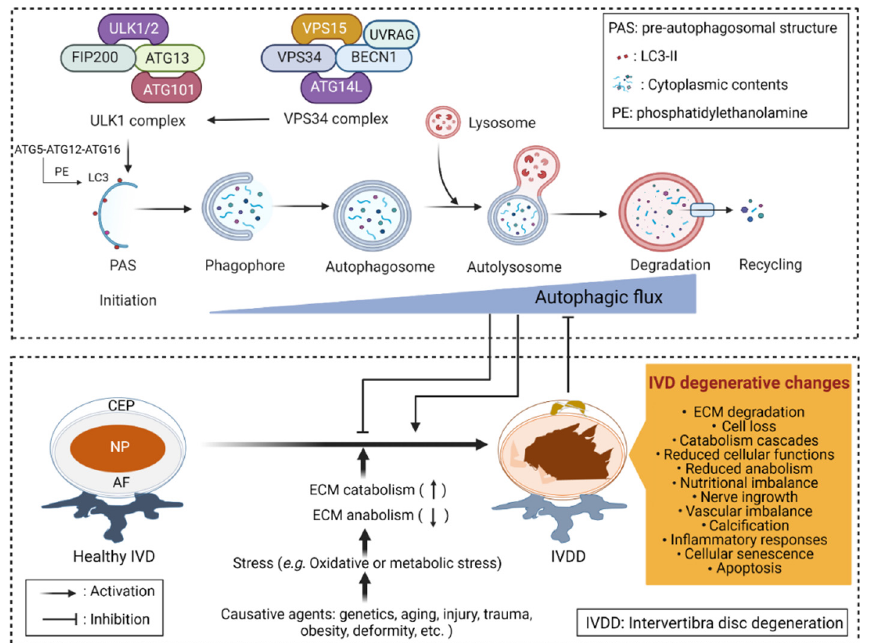
Figure 3. Autophagy and IVDD. Autophagic flux refers to the entire process of autophagy, including autophagosome formation, maturation, fusion with lysosomes, subsequent breakdown, macromolecule release back into the cytosol. Excessive stress, aging, injury, spine deformity, genetic predisposition, and other pathogenic factors contribute to IVDD progression. IVDD is associated with structural and morphologic abnormalities, nutritional imbalances, nerve and vascular in-growth, decreased cellular anabolic function, activating catabolic cascades, elevated chondrocyte calcification, increased cell senescence and apoptosis, and altered expression of ECM and inflammatory markers. Autophagic flux may either delay or accelerate the onset of IVDD.